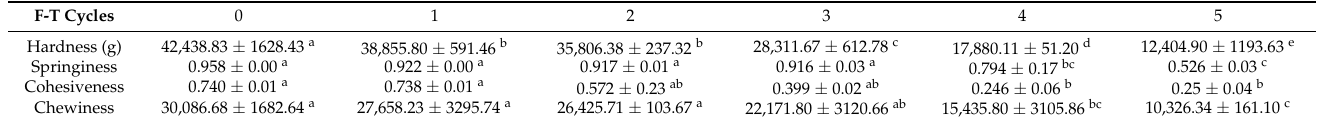
Table 2. Texture profile analysis change of cuttlefish flesh that had undergone repeated freeze–thaw cycles.